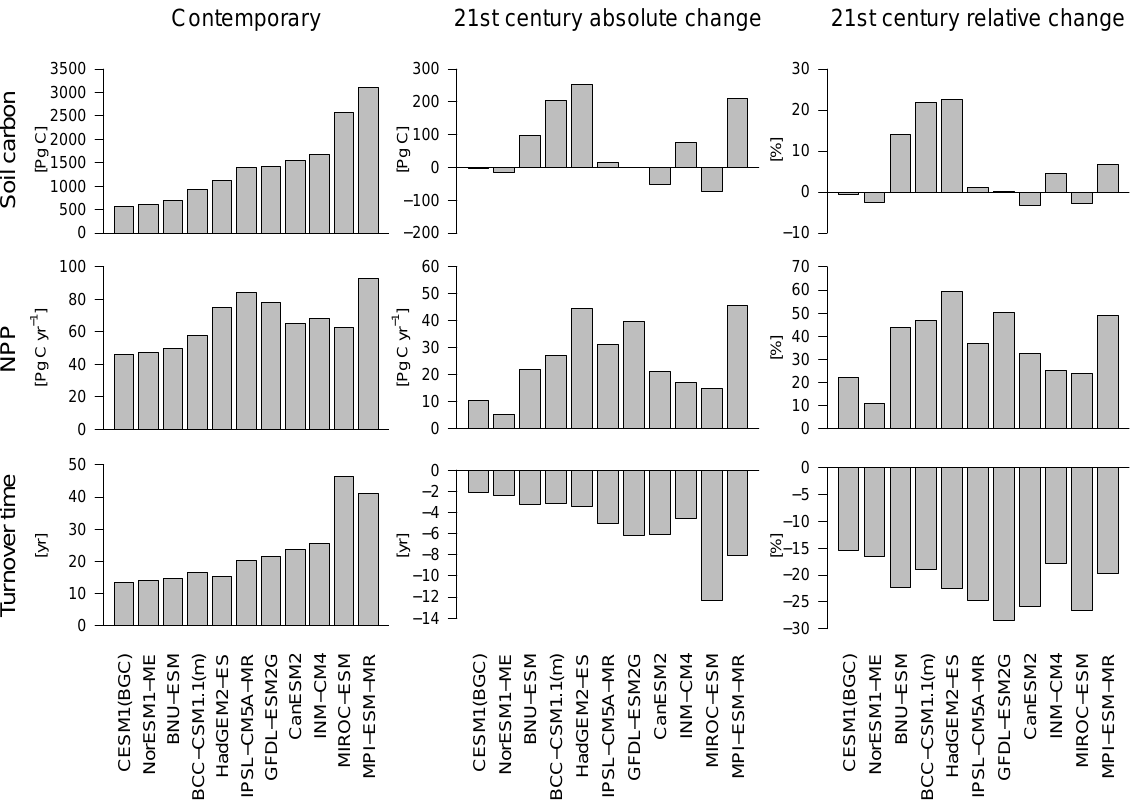
Fig. 1. Contemporary values, absolute changes, and relative changes of soil carbon, net primary production (NPP), and turnover times for CMIP5 Earth system models. Contemporary values of soil carbon, NPP, and turnover times are reported for the 1997–2006 mean using model output from the historical experiment. Changes for the 21st century were estimated from the difference between 2090–2099 and 1997–2006 mean model estimates from the RCP 8.5 experiment. Turnover times were calculated from global soil carbon stocks divided by global heterotrophic